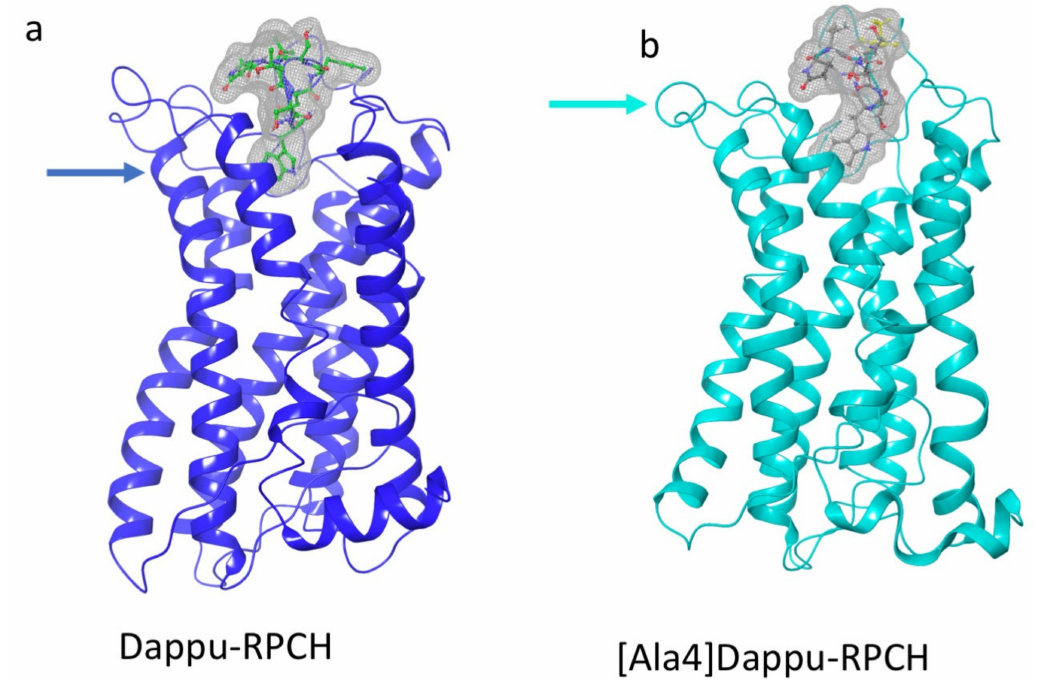
Figure 7. Snapshots taken from a trajectory in a POPC membrane of Dappu-RPCH and [Ala4]Dappu-RPCH bound to Dappu-RPCHR. ( a ) Dappu-RPCH bound to Dappu-RPCH R. ( b ) [Ala4]Dappu-RPCH bound to Dappu-RPCH R. The surface of the ligands is displayed as a mesh. An arrow indicates where the helix closes onto Dappu-RPCH but does not with